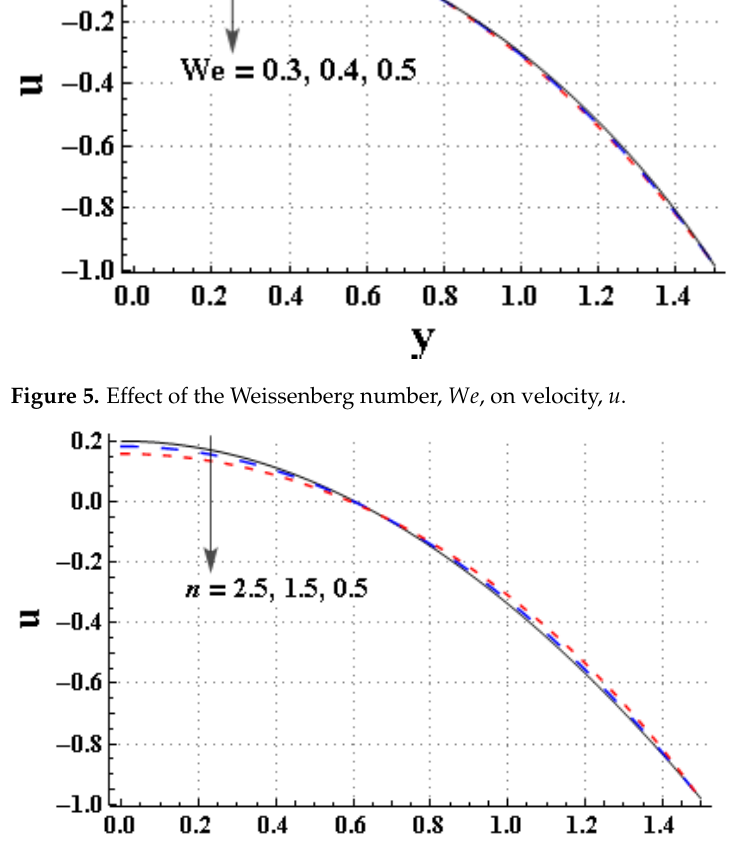
n , on velocity, u .